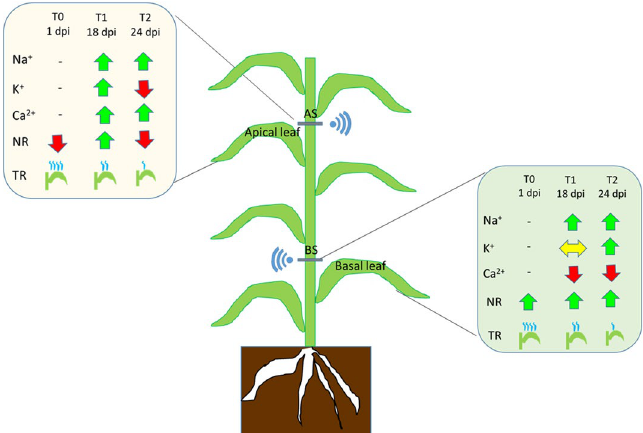
Figure 7. Qualitative visualisation of the bioristor (NR, normalized sensor response); TR, (transpiration rate) and plant ions concentration (Na + , sodium; K + , potassium; Ca 2+ , calcium) measured in